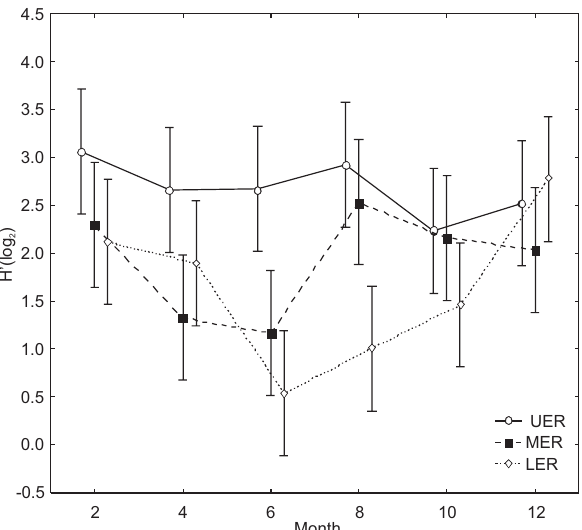
Figure 3. Average Shannon-Wiener diversity index (log trawls carried out in each of the three zones of the Rio Formoso: upper (UER), mid (MER), and lower (LER). The vertical bar corre- sponds to the 95% confidence interval. The months of February, April, June, August, October, and December are represented by 2, 4, 6, 8, 10, and 12, respectively. UER (n = 1837), MER (n = 3067), LER (n = 571).